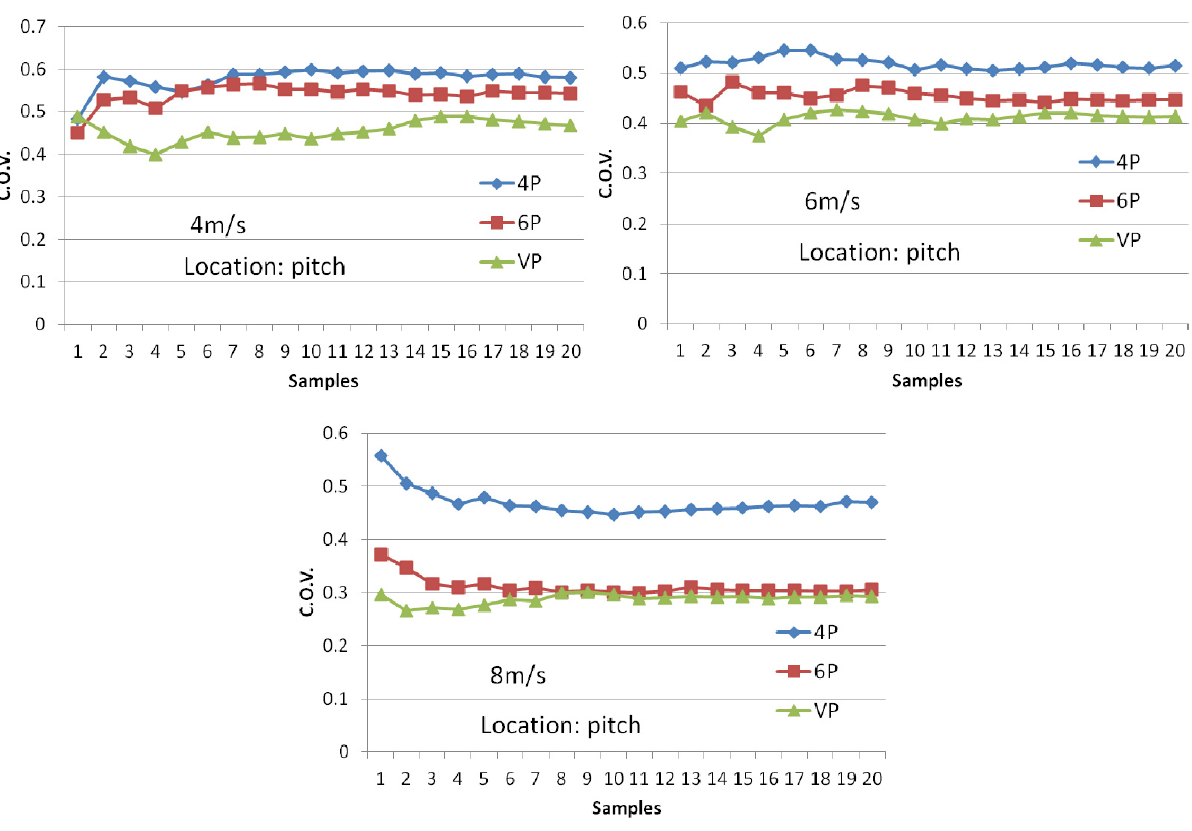
Figure 18. Variation of C.O.V. of the contact forces when using different controllers at the pitch contact